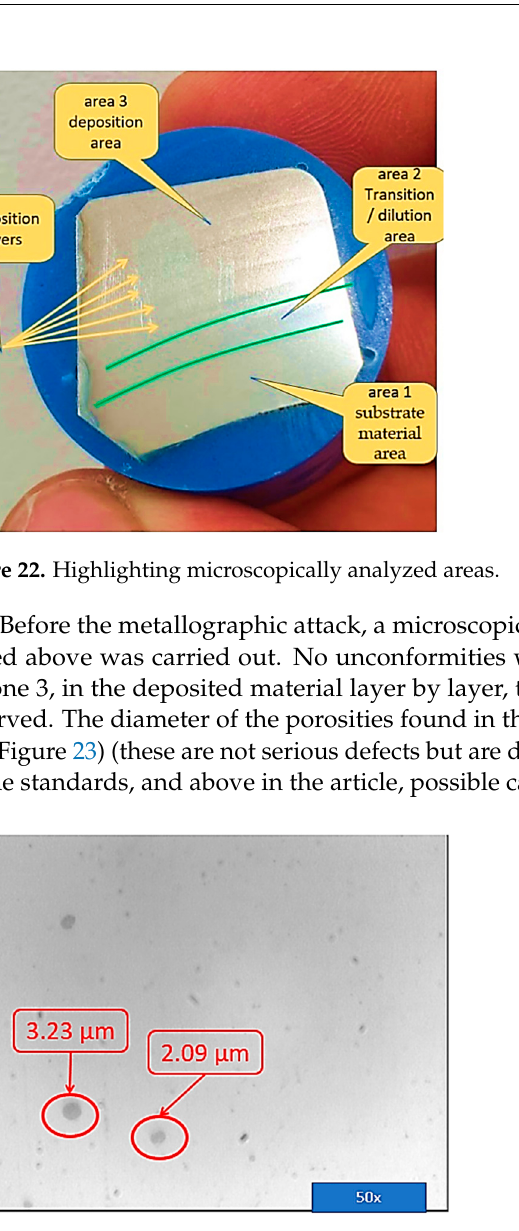
Figure 23. Microscopic porosities. Dimensional control of the porosities.